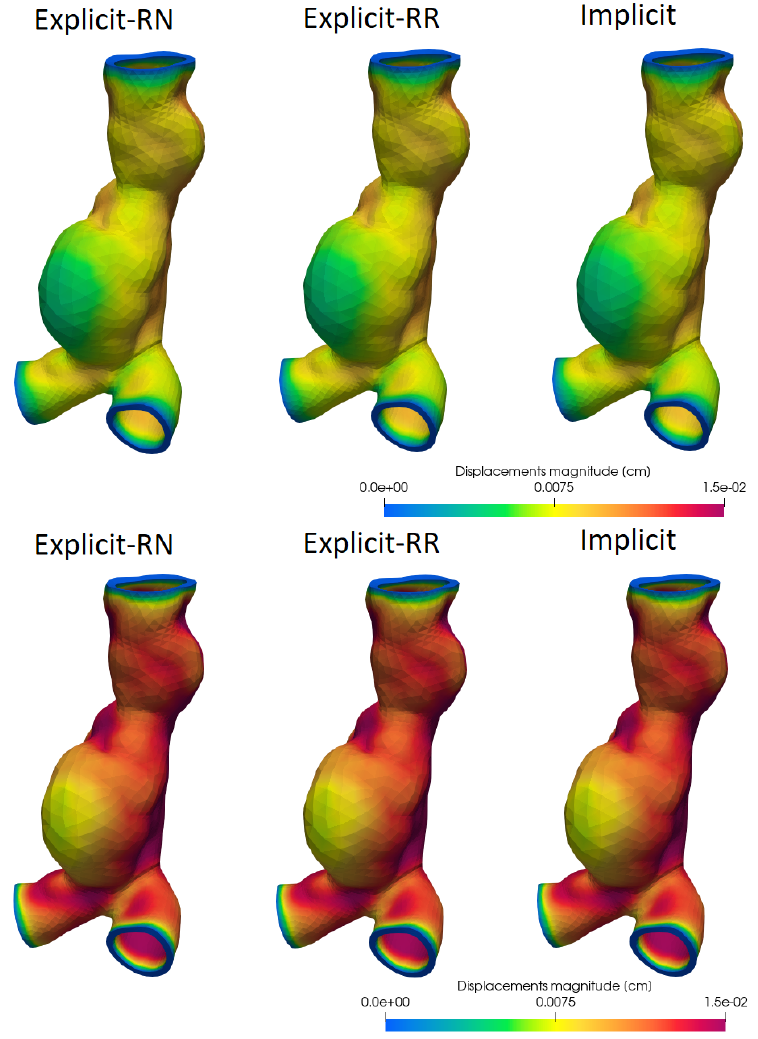
Figure 5. Displacements magnitude for the AAA simulation. Top: t = 0.05 s; Bottom: t = 0.1 s. Test